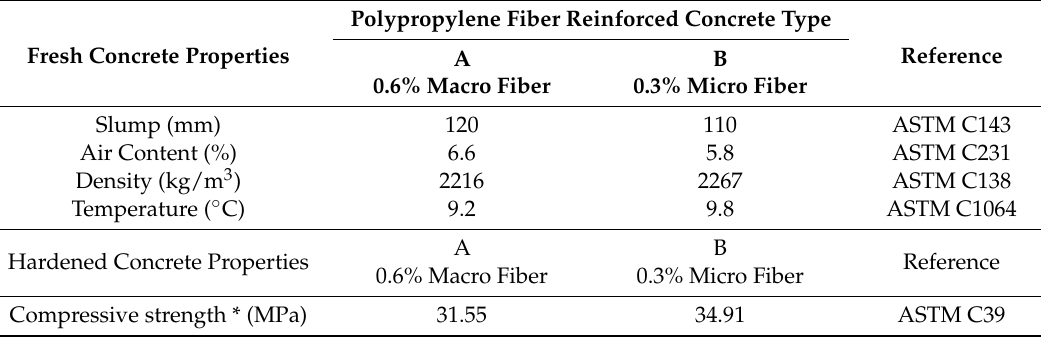
Table 6. Standard properties of fresh and hardened